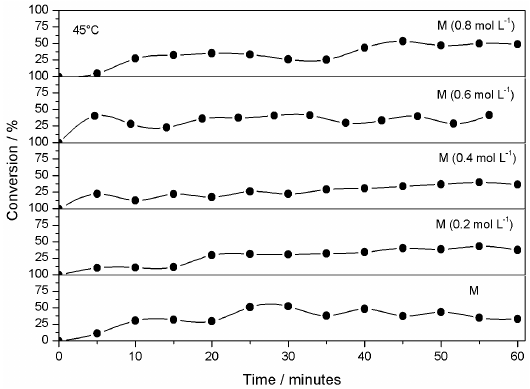
Figure 4. Conversion of oleic acid at 45 °C, using natural montmorillonite clay and treated montmorillonite clay with sulfuric acid at different concentrations (0.2 – 0.8 mol L –1 ).